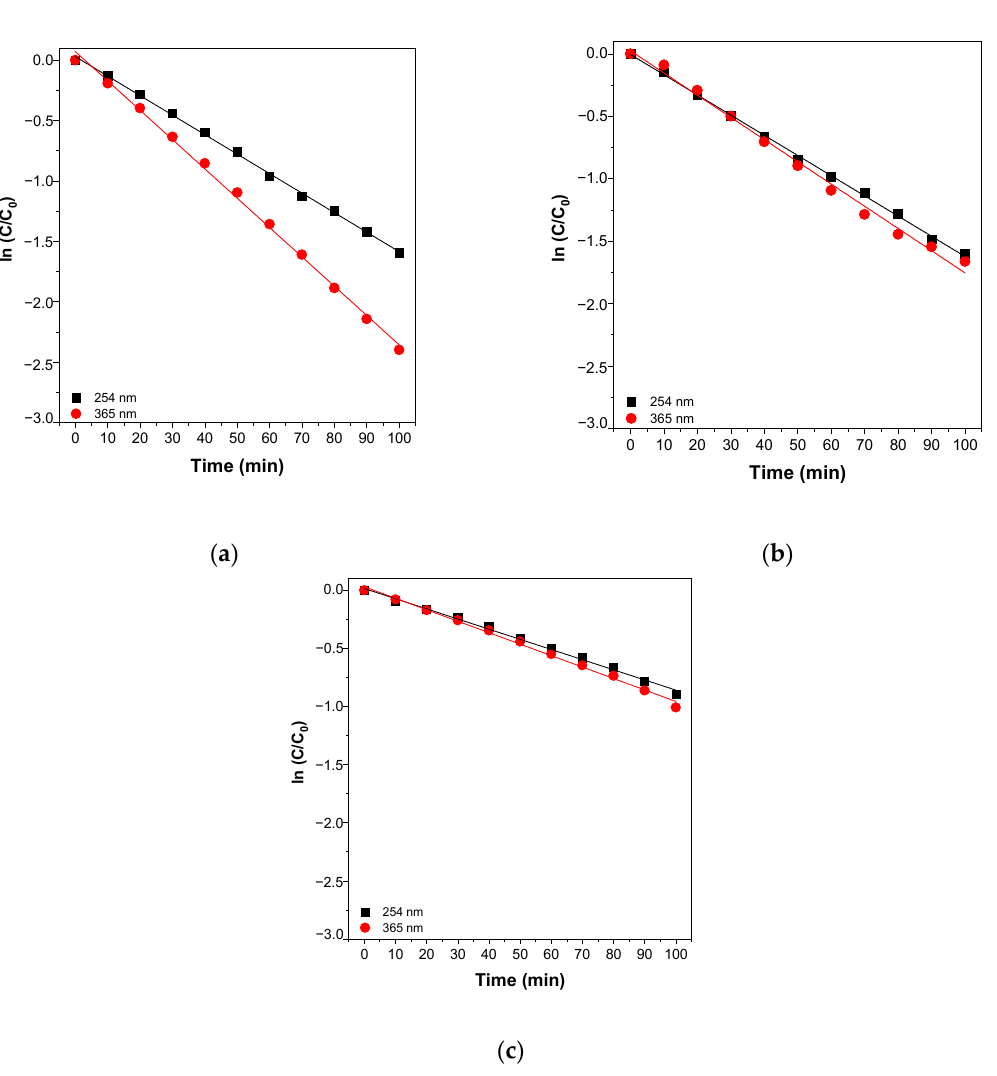
Figure 12. The effect of UV radiation wavelength on kinetics of the photocatalytic degradation of the azo dyes: ( a ) MO, ( b ) AO7, and ( c ) AY23 by Gd 2 O 3 nanoparticles in the presence of H 2 O 2 at pH 5.5. (Experimental conditions: initial dye concentration 0.042 mM; wavelength of UV irradiation: 254 nm or 365 nm; H 2 O 2 concentration: 4.8 M; photocatalyst concentration: 1.0 g/L.). Table 3. Reaction rate constant ( k ) and photocatalytic degradation efficiencies (%) of Gd 2 O 3 nanoparticles for the degradation of the azo dyes MO, AO7, AY23 in the presence of H 2 O 2 at different UV wavelengths. Azo Dye